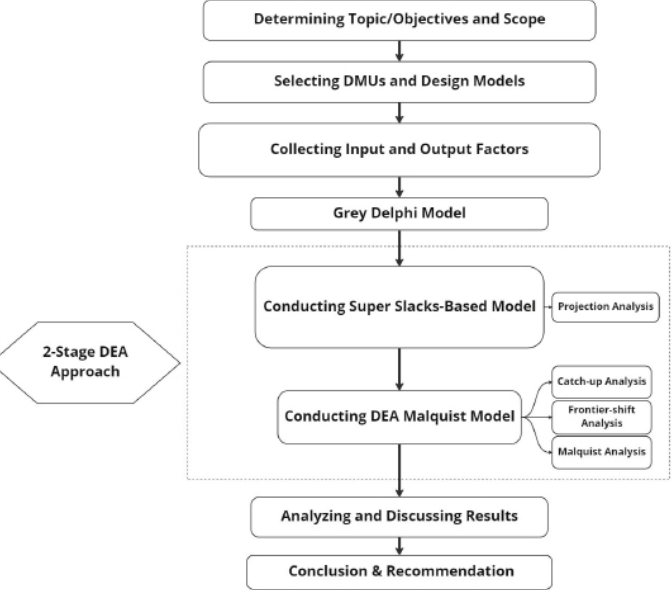
Figure 1. Research framework.